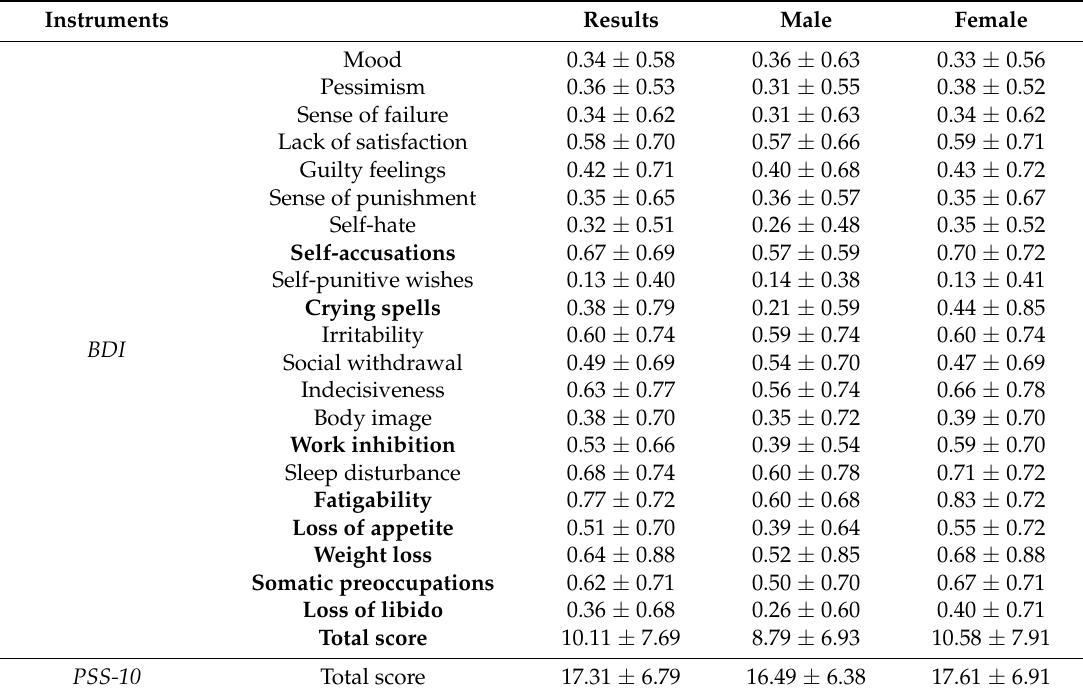
Table 4. Results for PSS-10 and BDI considering